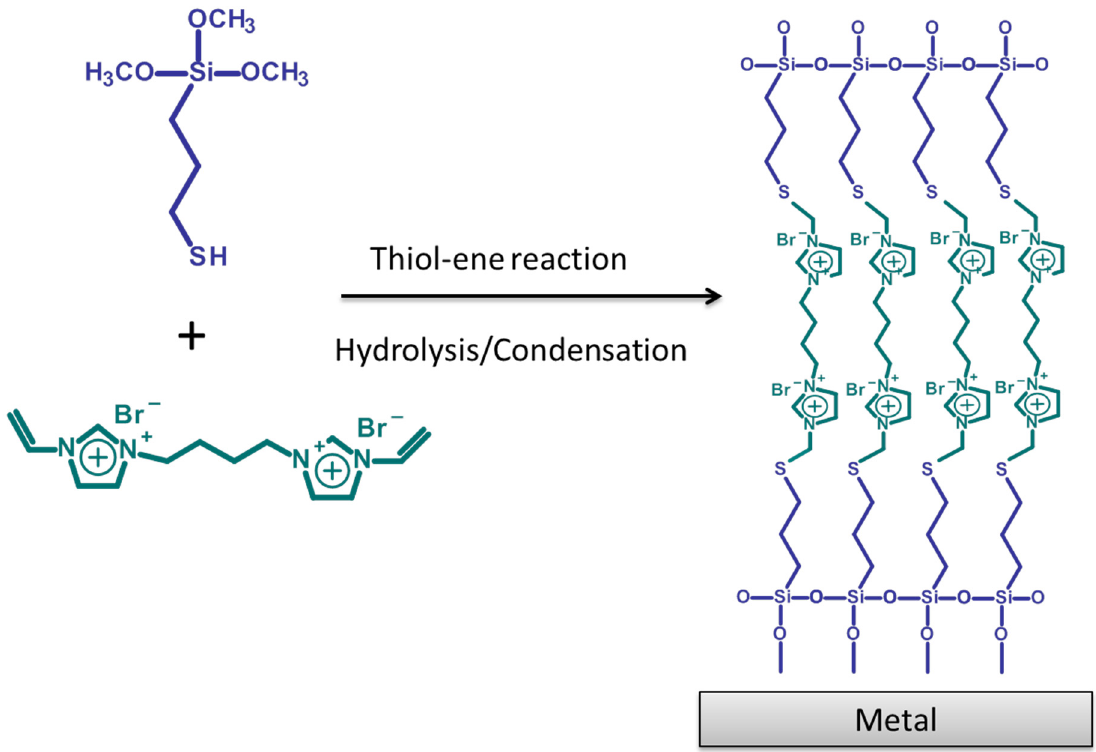
Figure 1. Proposed structure of the MPTS-DVIMBr hybrid film coated on metallic substrate.